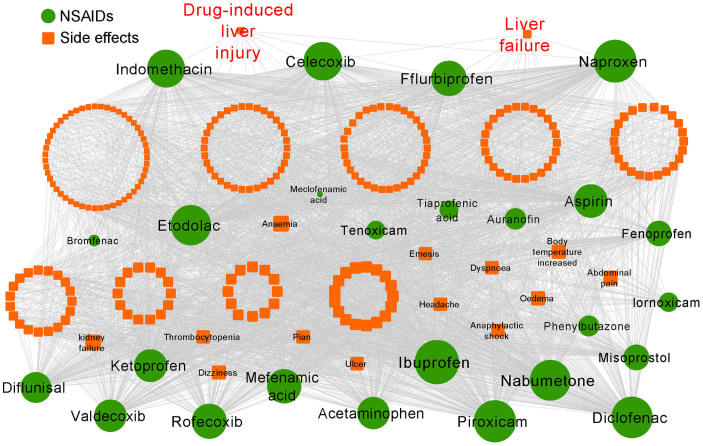
The NSAID-SE association network.In the network, nodes represent NSAIDs (Non-steroidal anti-inflammatory drug, green circles) and side effects (SE, gold squares) that were caused by at least 10 different NSAIDs, and where edges represent clinically reported drug-SE pairs. The size of NSAID and SE nodes is the number of NSAID-SE pairs (Degree). This graph and Figure 3 are prepared by Cytoscape (v2.8.3; http://www.cytoscape.org/).